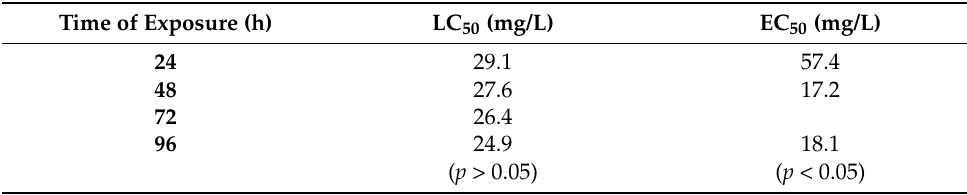
Figure 7. ( A ) Malformations in zebrafish embryos exposure to curcumin-loaded micelles. ( a ) Control at 24 h; ( b ) 24 h of exposure at 30 mg/mL, the yolk turned yellow without observable elongation; ( c ) 24 h of exposure at 45 mg/mL, yellow chorion and no elongation; ( d ) control at 48 h; ( e ) 48 h of exposure to 20 mg/mL, yellow yolk, no observable embryonic segmentation, no eye nor body pigmentation; ( f ) 48 h of exposure at 30 mg/mL, yellow and necrosed yolk, no embryonic segmentation nor pigmentation; ( g ) control at 96 hpf; ( h ) 96 h of exposure at 20 mg/mL, black and necrosed yolk, congested blood circulation in the tail; ( i ) After 96 h of exposure at 30 mg/mL, the larvae could not escape from the chorion, showing necrosis in the tail and yolk and pericardial edema. ( B ) The dose-response curve of nanocurcumin on zebrafish embryos. The data are presented as mean ± SD, N = 3. Table 2. Toxicity of curcumin-loaded micelles in zebrafish embryos. Time of Exposure